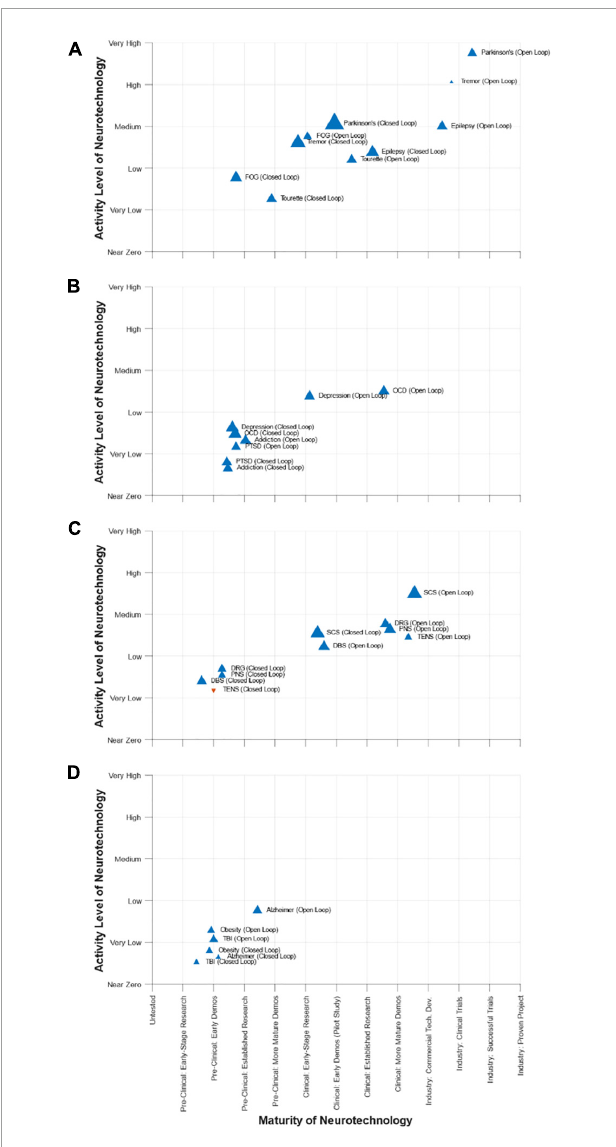
FIGURE8 DBS-Think-Tank Neurotechnology Activity-Maturity Graphs–This figure presents four graphs that illustrate the perceptions of DBS-Think-Tank attendees about the maturity, activity, and change in activity of a variety of neurotechnologies. The neurotechnologies are organized into the following four groups and graphed separately: (A) movement disorders, (B) psychiatric disorders, (C) pain disorders, and (D) other syndromes. The upward pointing blue triangles represent increasing activity and downward pointing orange triangles represent decreasing activity. The magnitude of the rate of change is proportional to the size of the triangles. The definitions of the abbreviations used to identify each triangle are as follows: DBS, deep brain stimulation; FOG, freezing of gait; OCD, obsessive-compulsive disorder; PTSD, posttraumatic stress disorder; PNS, peripheral